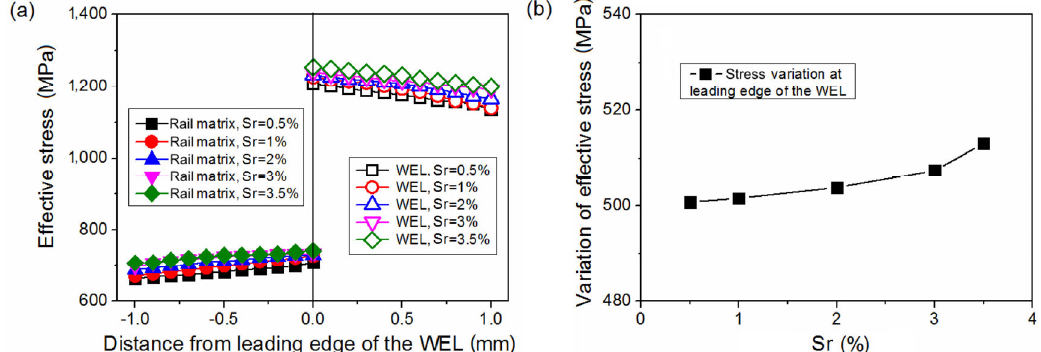
Fig. 10 (a) Distribution of effective stress around leading edge of the WEL under different Sr conditions and (b) variation of effective stress between the WEL and rail matrix as a function of